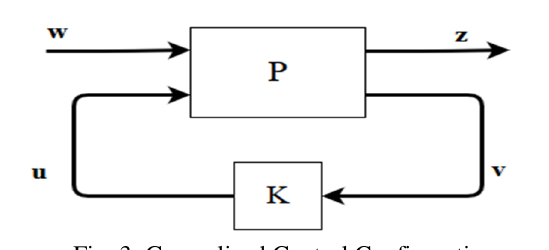
Fig. 3: Generalized Control Configuration